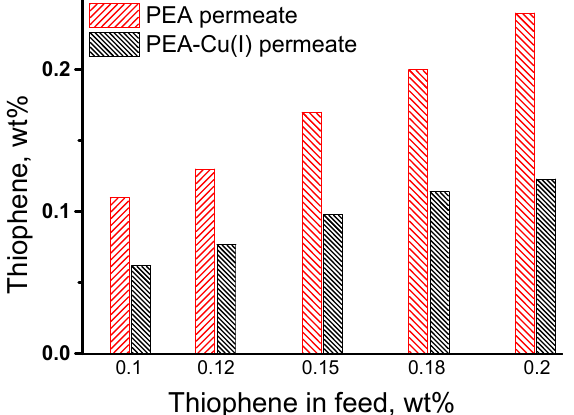
Figure 7. Comparison of the thiophene concentration in the feed and in the permeate after pervaporation of the thiophene/ n -heptane using PEA and PEA–Cu (I) membranes, 20 ° С .